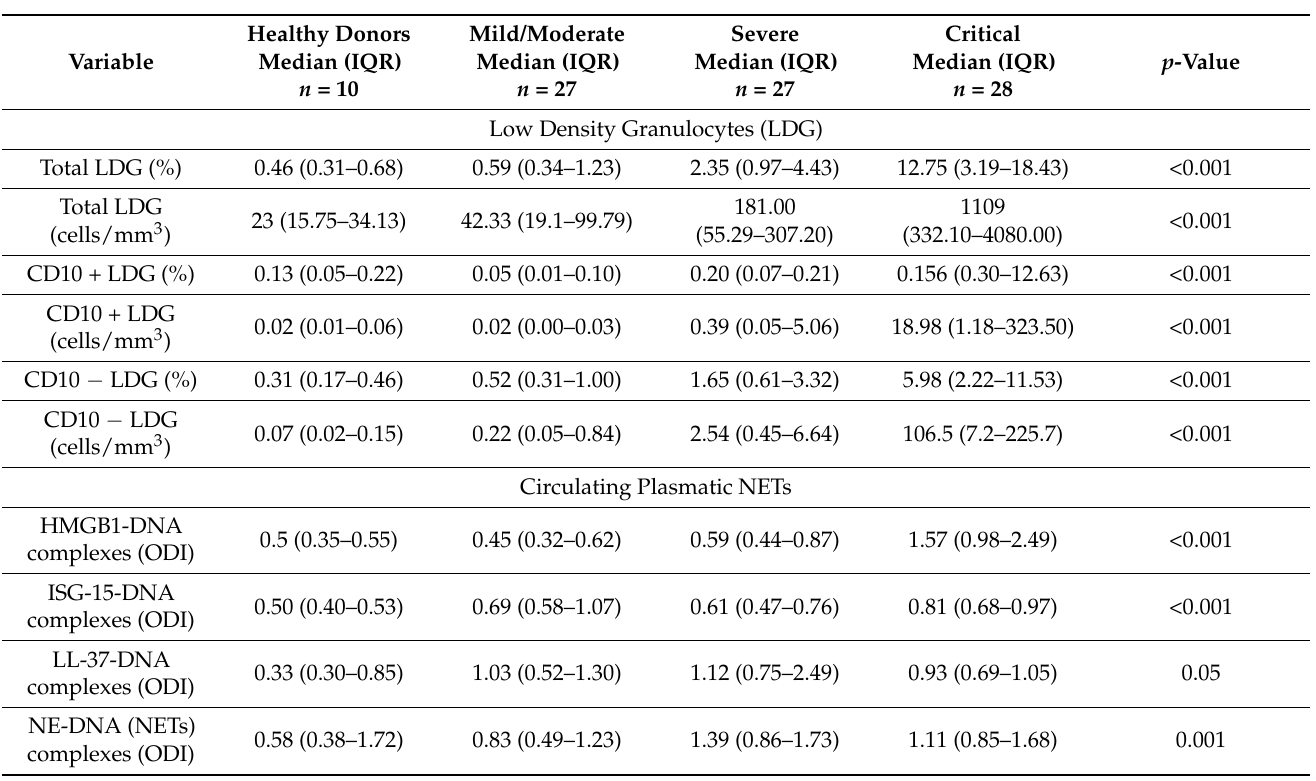
Table 1. Proportion of LDG subsets and plasmatic NET complexes in healthy donors and COVID-19 patients according to disease